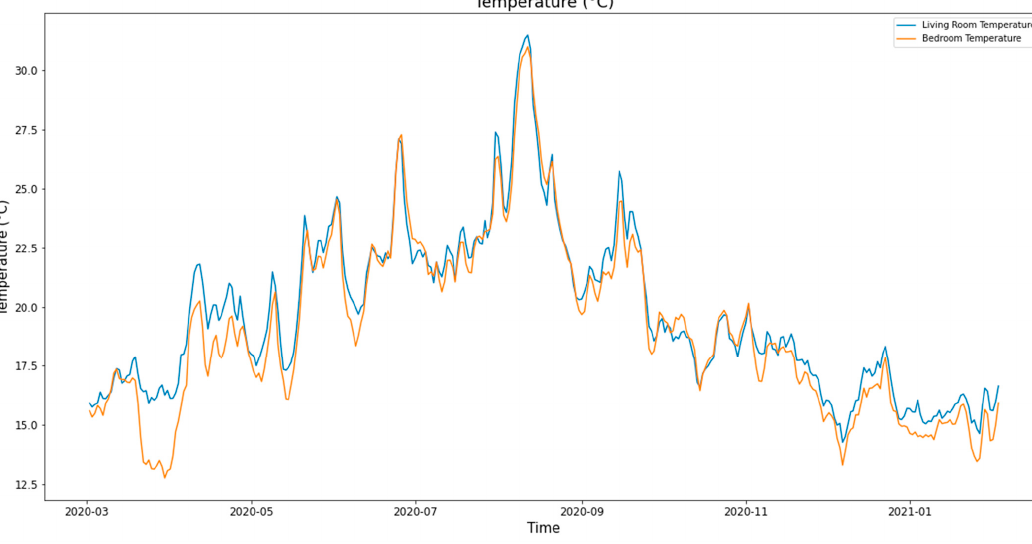
Sensors 2021 , 21 , 5810